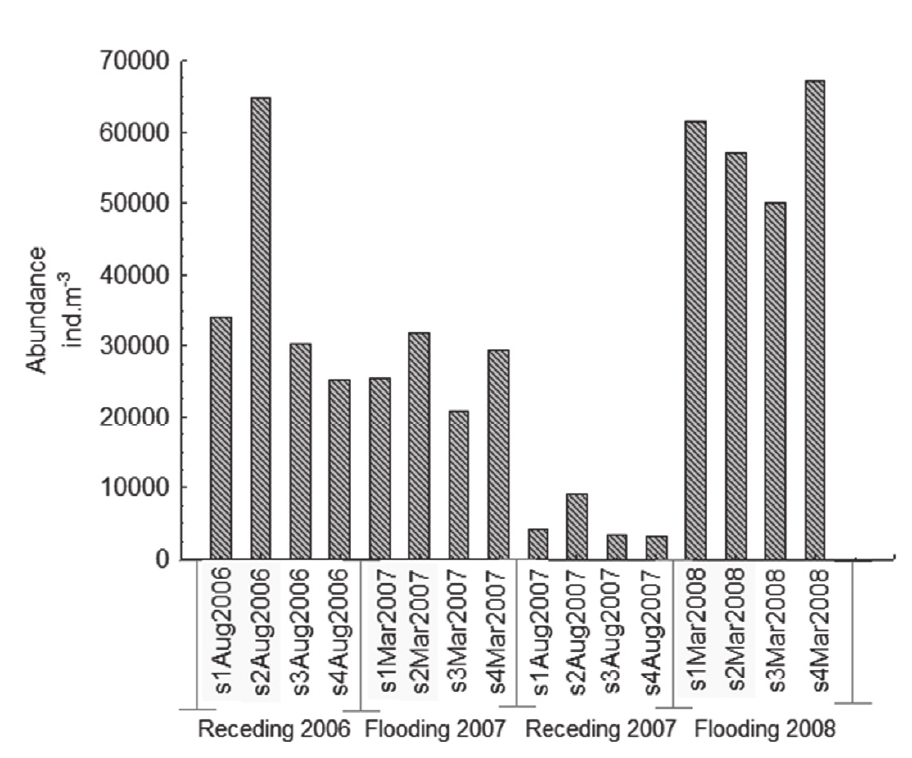
Figure 4 - Total abundance (ind.m -3 ) of rotifers during fl ooding (August) and receding (March) phases of two consecutive years in all the sampling stations (s1, s2, s3 and